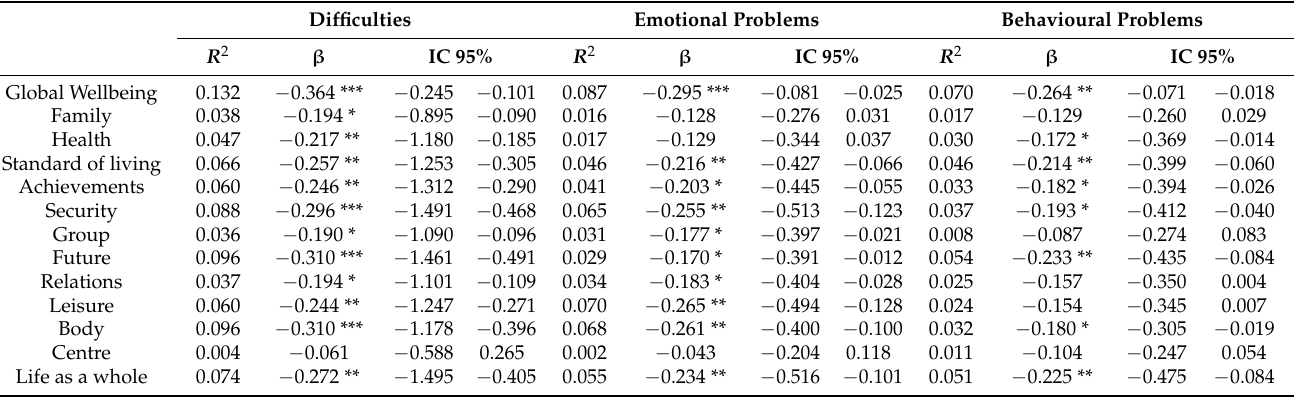
Table 5. Linear regression analysis between the adolescents’ emotional and behavioural difficulties and their personal wellbeing (I). Difficulties Emotional Problems Behavioural Problems